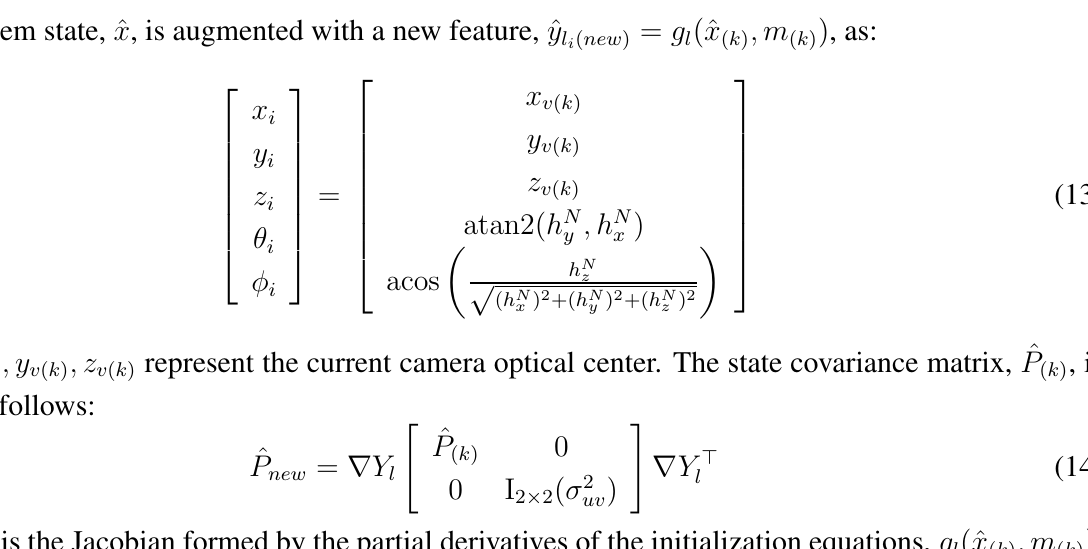
Figure 3. Model measurement for features, ˆ y